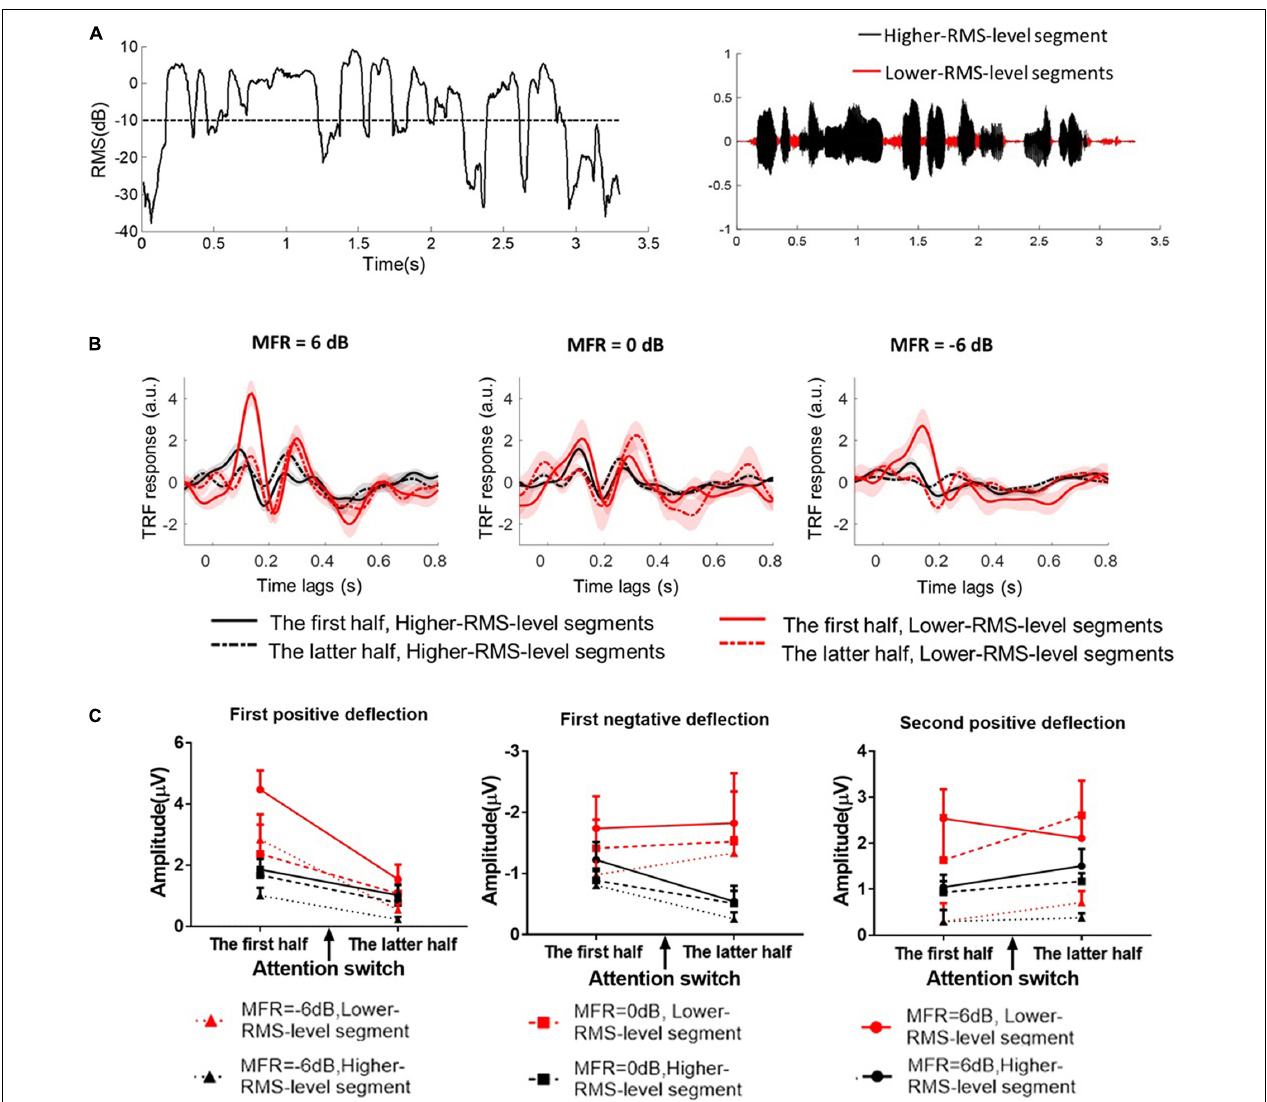
FIGURE 2 | (A) The root mean square (RMS) level of a short fragment in the continuous speech stimulus. The dashed line indicates the threshold (–10 dB relative RMS level) to classify higher- and lower-RMS-level speech segments within the continuous utterance. The right figure shows the higher- and lower-RMS-level segments in the temporal series of a sentence. (B) The TRF responses calculated between speech envelopes and the corresponding EEG signals in 6–, 0–, and –6-dB MFR conditions. The TRF responses between higher-RMS-level speech segments and EEG signals were displayed with the black solid line in the first half (i.e., before attention switching) and with the black dashed line in the latter half (i.e., after attention switching) of the whole trial. The right solid line in the first half (i.e., before attention switching) and the right dashed line in the latter half (i.e., after attention switching) of the whole trial were represented the TRF responses derived from lower-RMS-level speech segments and the corresponding EEG signals, respectively. (C) The amplitudes of the three typical TRF components with the lower-RMS-level segments (right lines) and higher-RMS-level segments (black lines) in –6 dB (dot lines with the rectangular sign), 0 dB (dashed lines with the